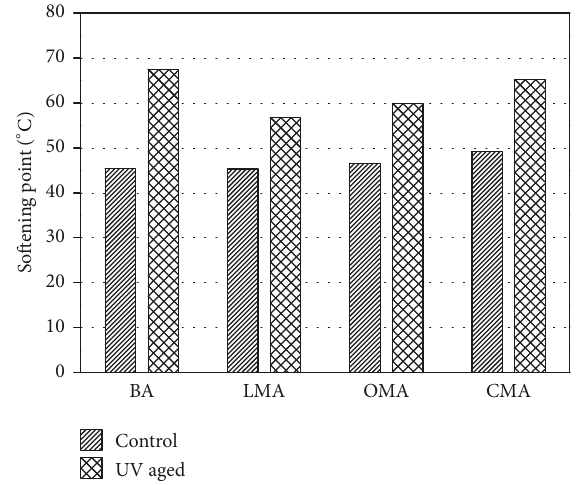
Figure 6: Softening point of UV aged and unaged